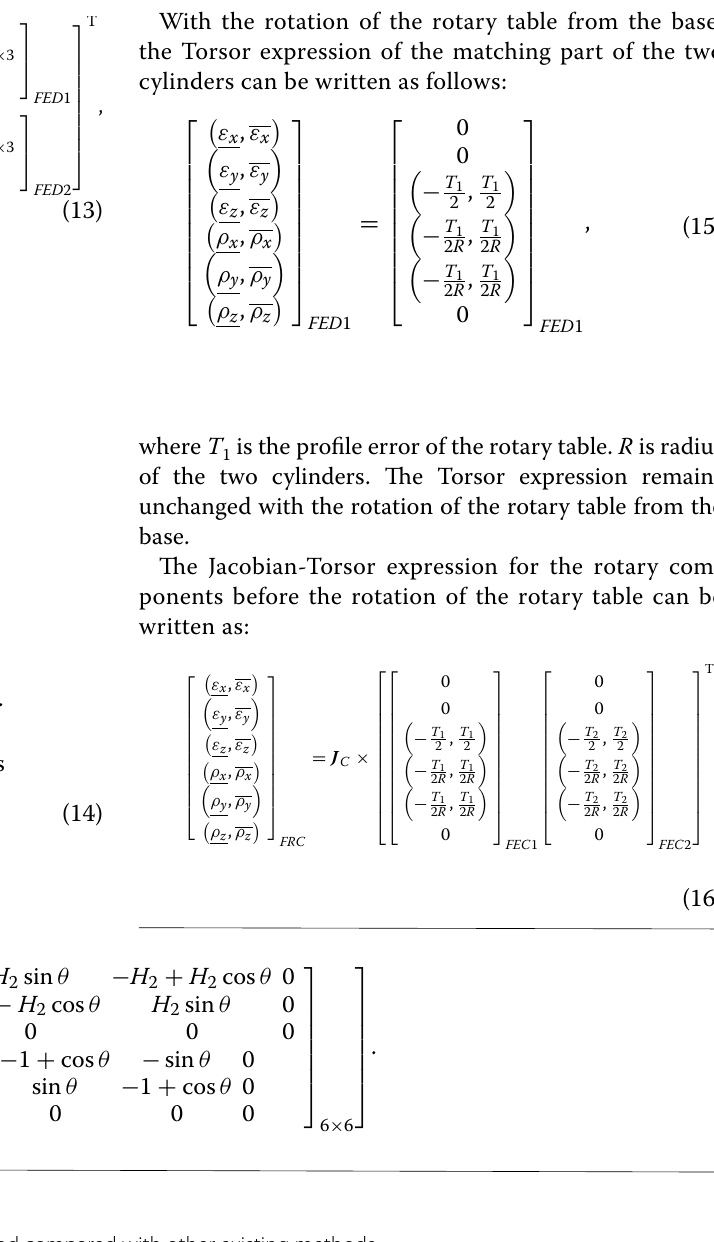
Table 1 The main advantages of the proposed method compared with other existing methods Methods Advantages and